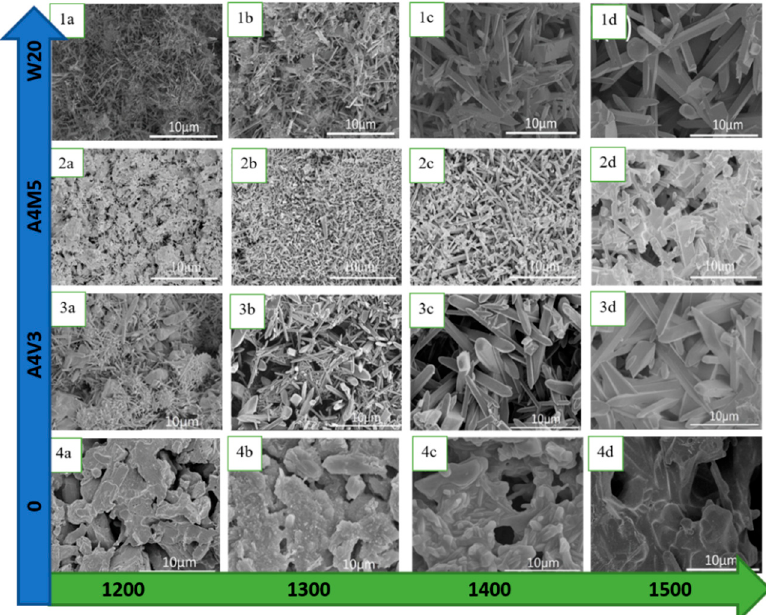
Figure 6. Formation of mullite from fly ash and bauxite at different temperatures with/without various sintering aids: 1a, 1b, 1c, 1d contain WO 3 , 2a, 2b, 2c, 2d contain MoO 3 , 3a, 3b, 3c, 3d contain V 2 O 5 , and 4a, 4b, 4c, 4d without sintering aid. Increasing sintering temperature leads to higher densification. Without any additives, platelet-like mullite crystals are formed; however, sintering aids promote the formation of mullite whiskers at lower temperatures, especially V 2 O 5 (adapted from ref. [120,121,123] with permission from American Chemical Society and